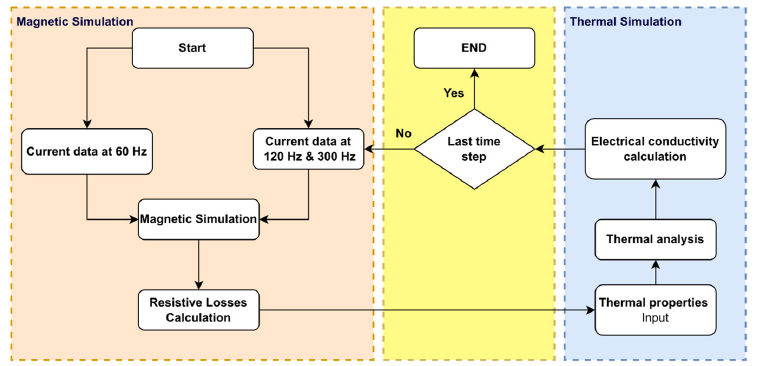
Figure 6. Flowchart for numerical simulations with strong thermo-magnetic coupling.